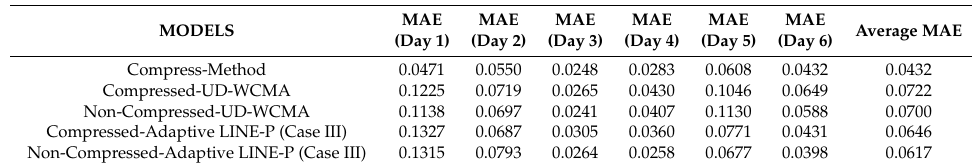
Table 16. Error estimation MAE of the prediction models with and without the compressed profile for the solar energy profile.